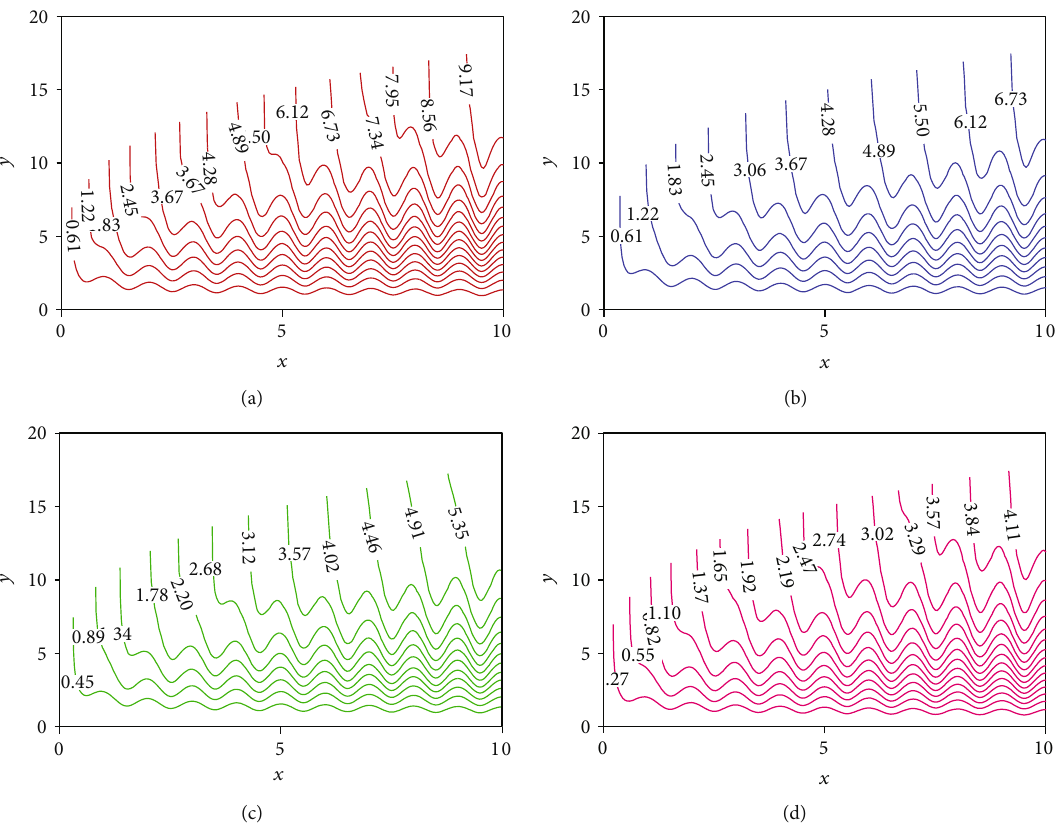
Figure 8: E ff ect of s treamlines for (a) Pr = 0 : 73 , (b) Pr = 1 : 73 , (c) Pr = 3 : 0 , and (d) Pr = 7 : 0 when α = 0 : 3 and γ = 0 : 05